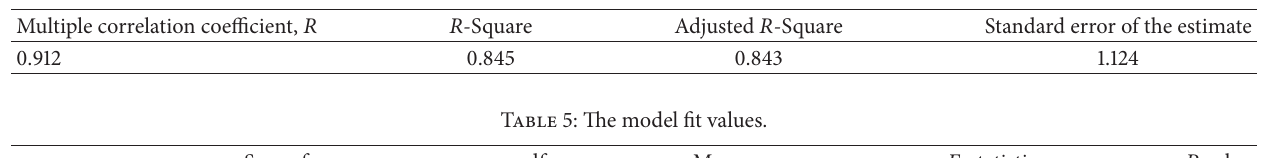
Table 4: The model summary.